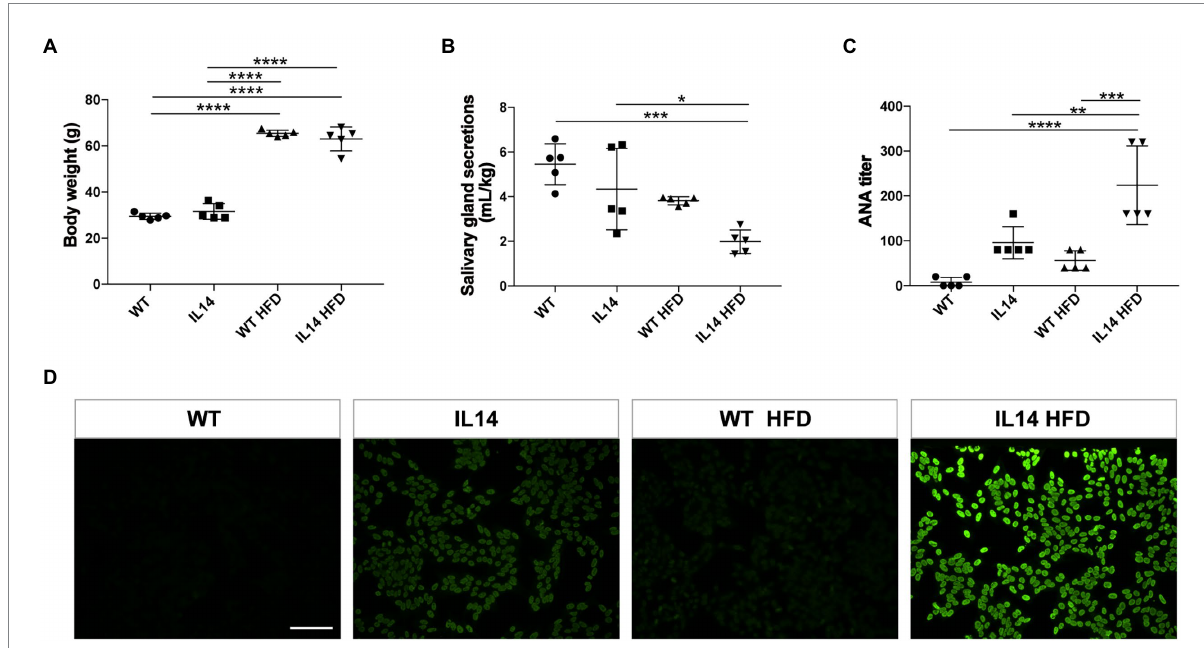
FIGURE 1 High-fat diet (HFD) increased autoantibody level and exacerbated dry mouth manifestation in the IL-14 α TG mice. (A) The body weight was increased after HFD. (B) Stimulated salivary gland secretions were measured and normalized to the body weight. (C) The results of the antinuclear antibodies (ANA) titer showed that the IL14 HFD group was significantly higher than the other three groups. (D) Hep-2 cells were directly stained by serum at 1:80 dilutional titer. * p ≤ 0.05; ** p ≤ 0.01; *** p ≤ 0.005; and **** p ≤ 0.001; n = 5 per group. Scale bars: 200 μ m for fluorescent